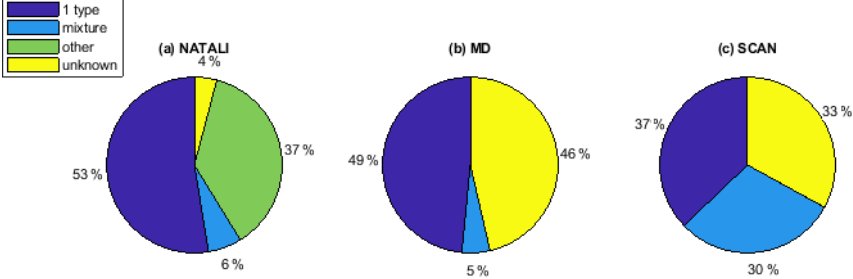
Figure 6. Percentages of classified aerosol layers by (a) NATALI, (b) MD, (c) SCAN. Blue: 1 type aerosol layers, cyan: mixtures, green: other types, yellow: unknown constitution of aerosol layers.